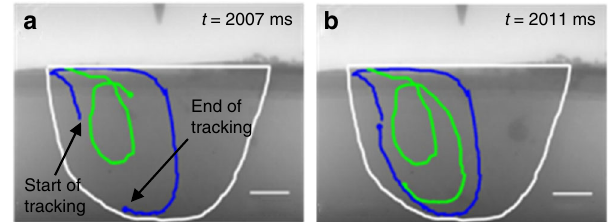
tracked from 1.00 to 1.008s. Two-time instances are assessed to demonstrate orientation tracked from 2.00 to 2.005s. d Repeated recirculation of the